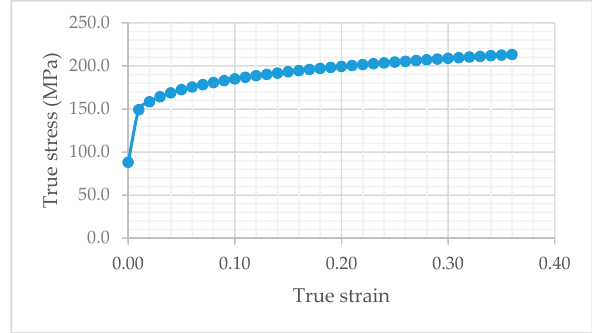
Figure 2. True stress-strain curve obtained from the tensile test.